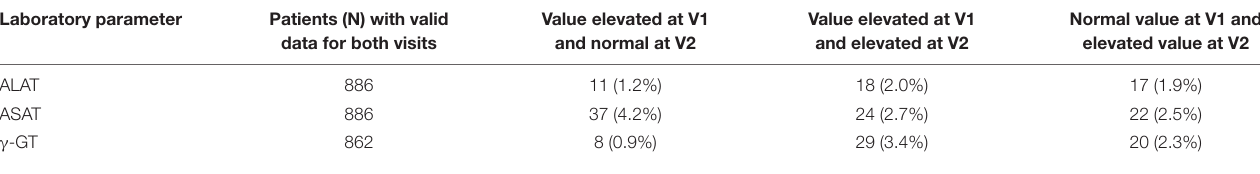
TABLE 2 | Numbers and percentage of patients with elevated serum liver enzyme activities (ELEA) at visits 1 (V1) and 2 (V2). Laboratory